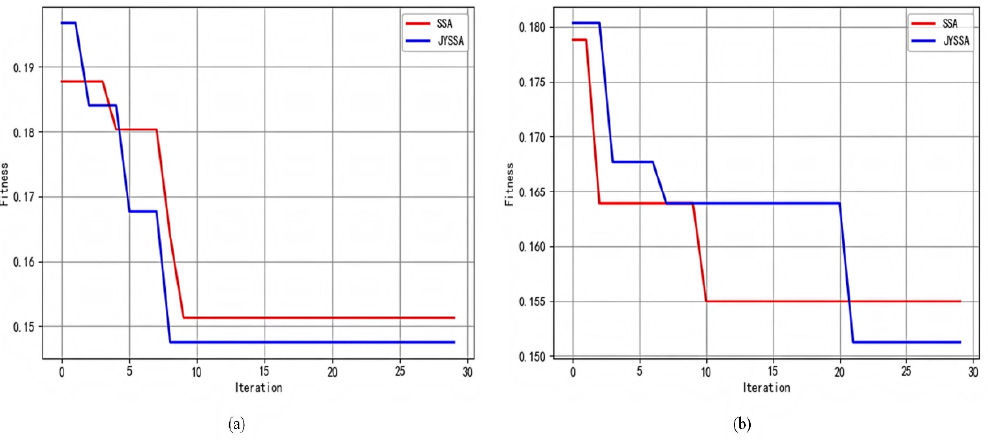
Figure 10. Convergence of algorithm adaptation curves: ( a ) convergence curves of 462 bands; ( b )